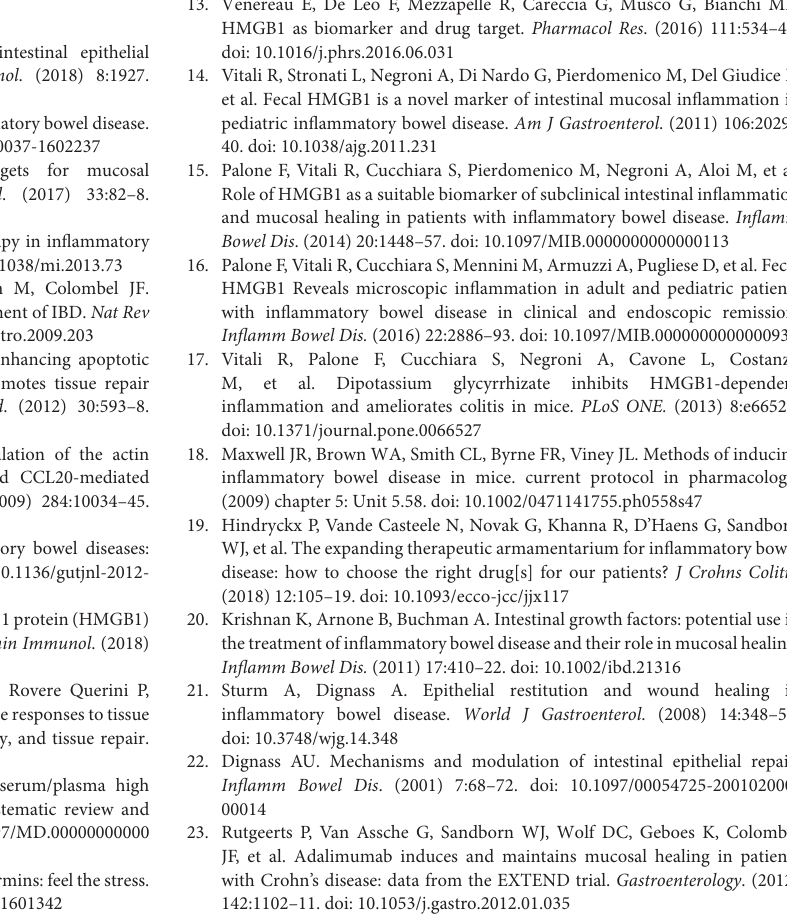
Supplementary Material 1 | Complete data set and False Discovery Rate of the microarray performed. Supplementary Figure 1 | DPG improves in vitro epithelial barrier functions and morphology. Zonulin-1 and F-actin expression and localization were determined by immunofluorescence in HT29. Treatment with DPG increases expression of (A) Zonulin-1 and reduces level of (B) F-actin altered by Cytomix. DPG significantly improved (C) wound healing in Caco2 cells, inhibited by Cytomix. UN, untreated cells; DPG, dipotassium